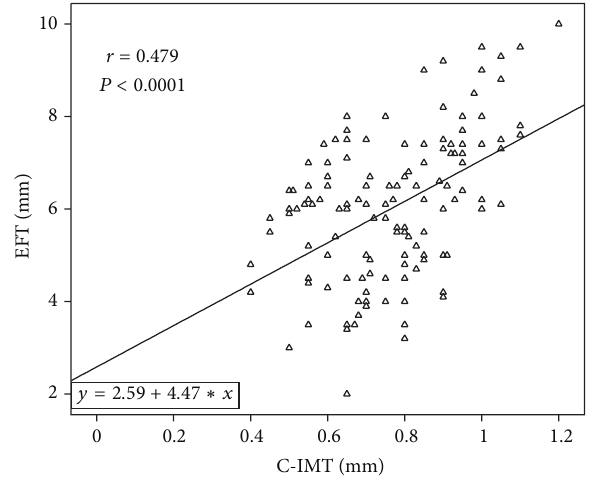
Figure 1: Epicardial fat thickness (EFT) is positively correlated with carotid intima-media thickness (CIMT) in diabetic patients. an indicator level of subclinical organ damage as proposed by ESC hypertension guideline [21], to determine cutoff high risk value of EFT in patients T2DM by receiver operating characteristic (ROC) curve analysis. In the ROC